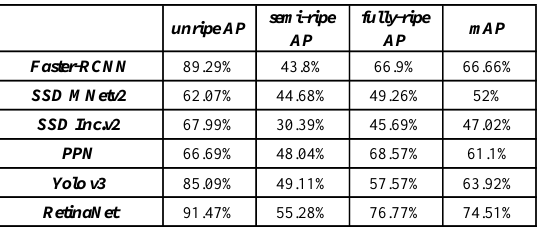
Table 3. Average precision of each class and mean Average Precision over all